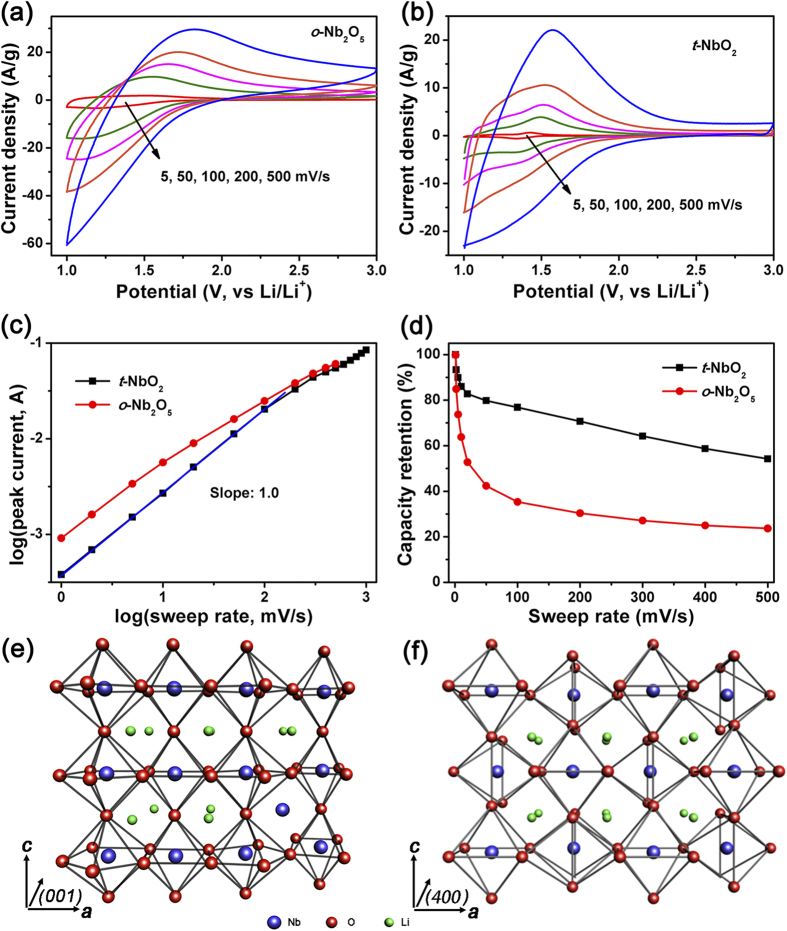
CV curves of commercial o-Nb2O5 powders (a) and t-NbO2 powders (b); the b-value of cathodic current peak (c); the capacity retention versus sweep rate (d); lithiated crystal structural schemes of o-Nb2O5 (e) and t-NbO2 (f).